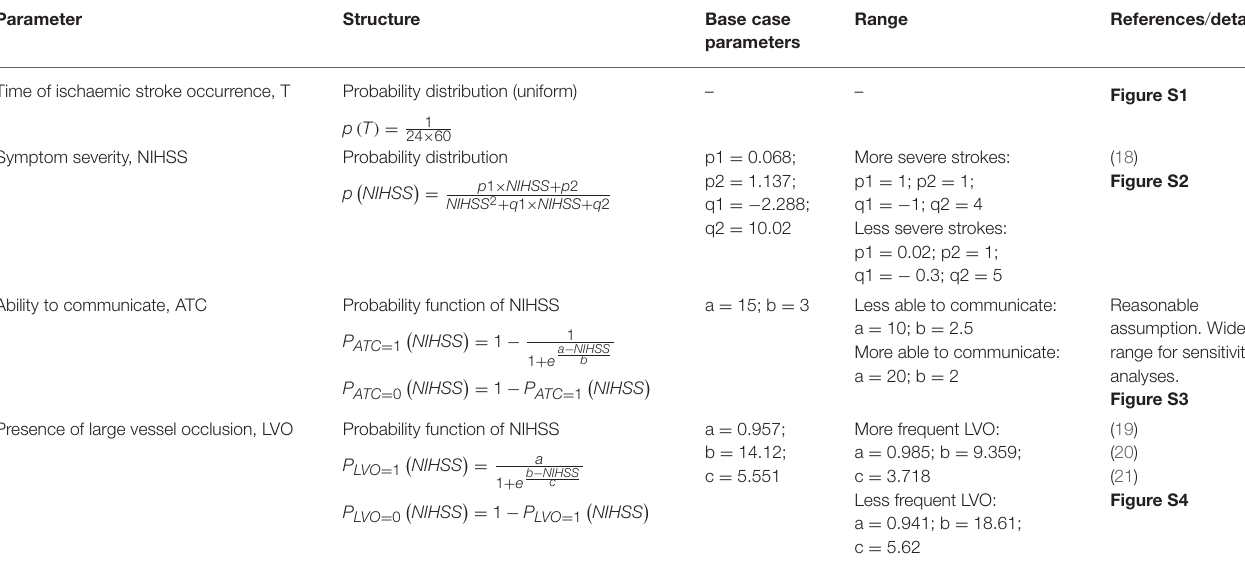
TABLE 2 | Clinical parameters used in the model.